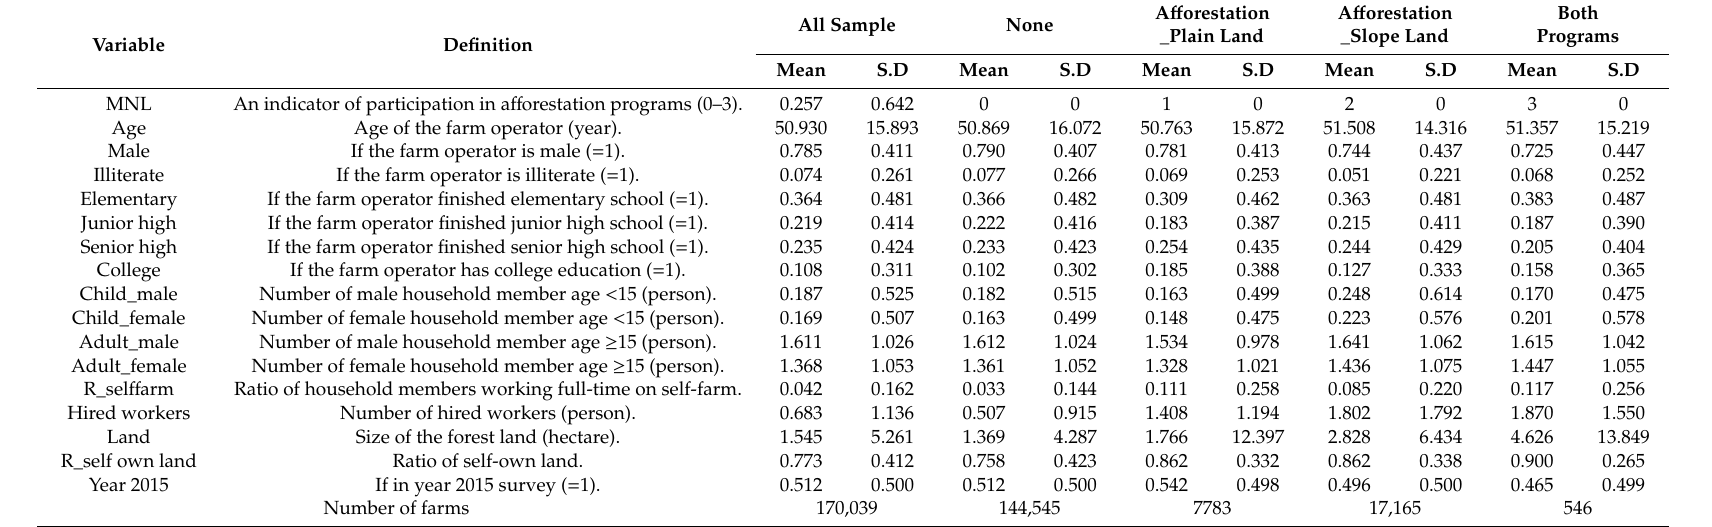
Table 1. Sample statistics of the selected